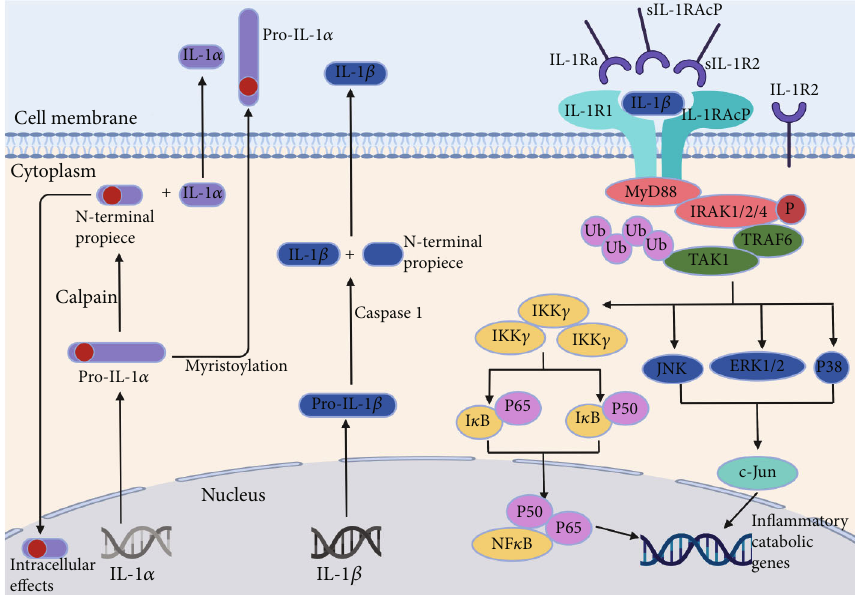
Figure 3: IL-1 α and IL-1 β synthesis and signal transduction pathways.